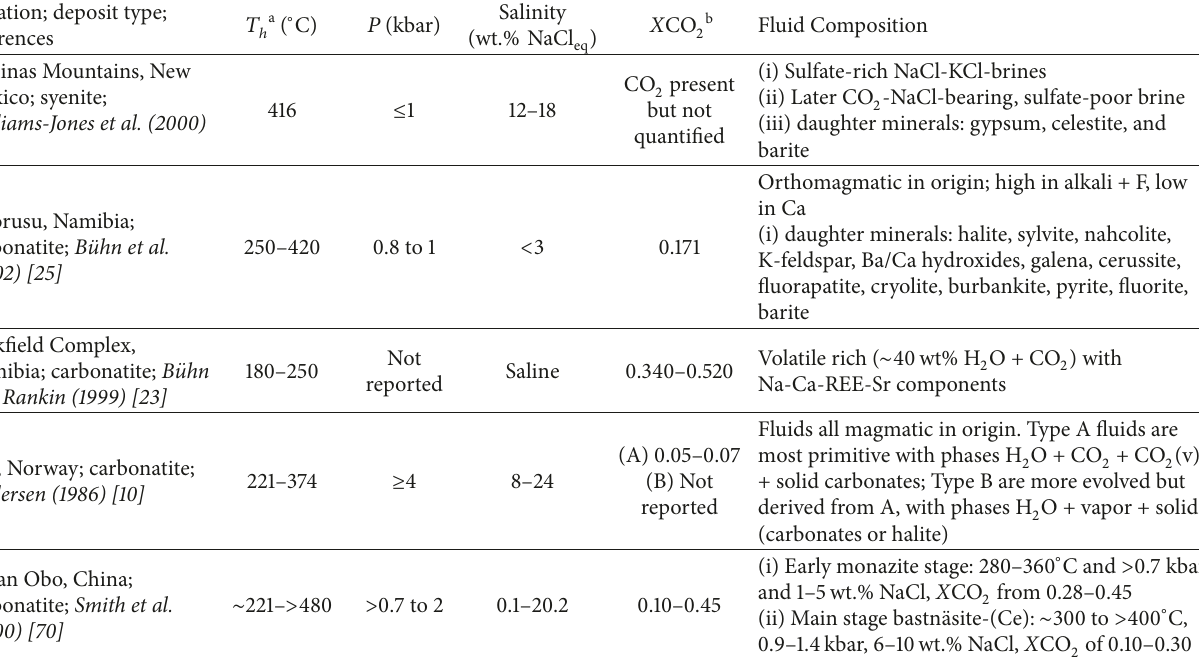
Table 4: Fluid characteristics of selected natural alkaline and carbonatite systems based on available fluid inclusion